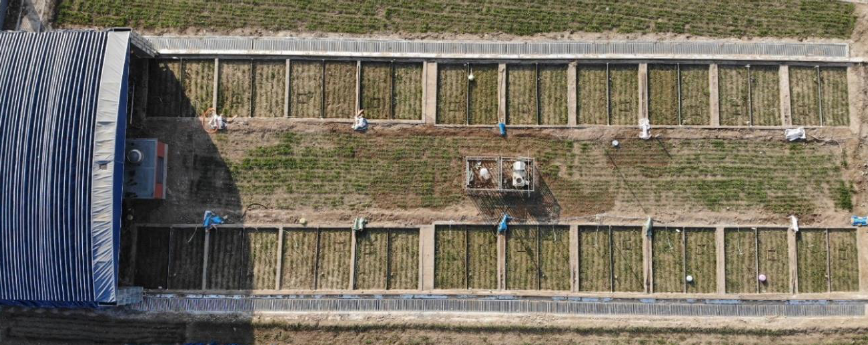
Figure 1. Field experiment of long-term monitoring lysimeter in Xinxiang Agricultural Water and Soil Environment Field Scientific Observation and Experiment Station, Chinese Academy of Agricultural Sciences.